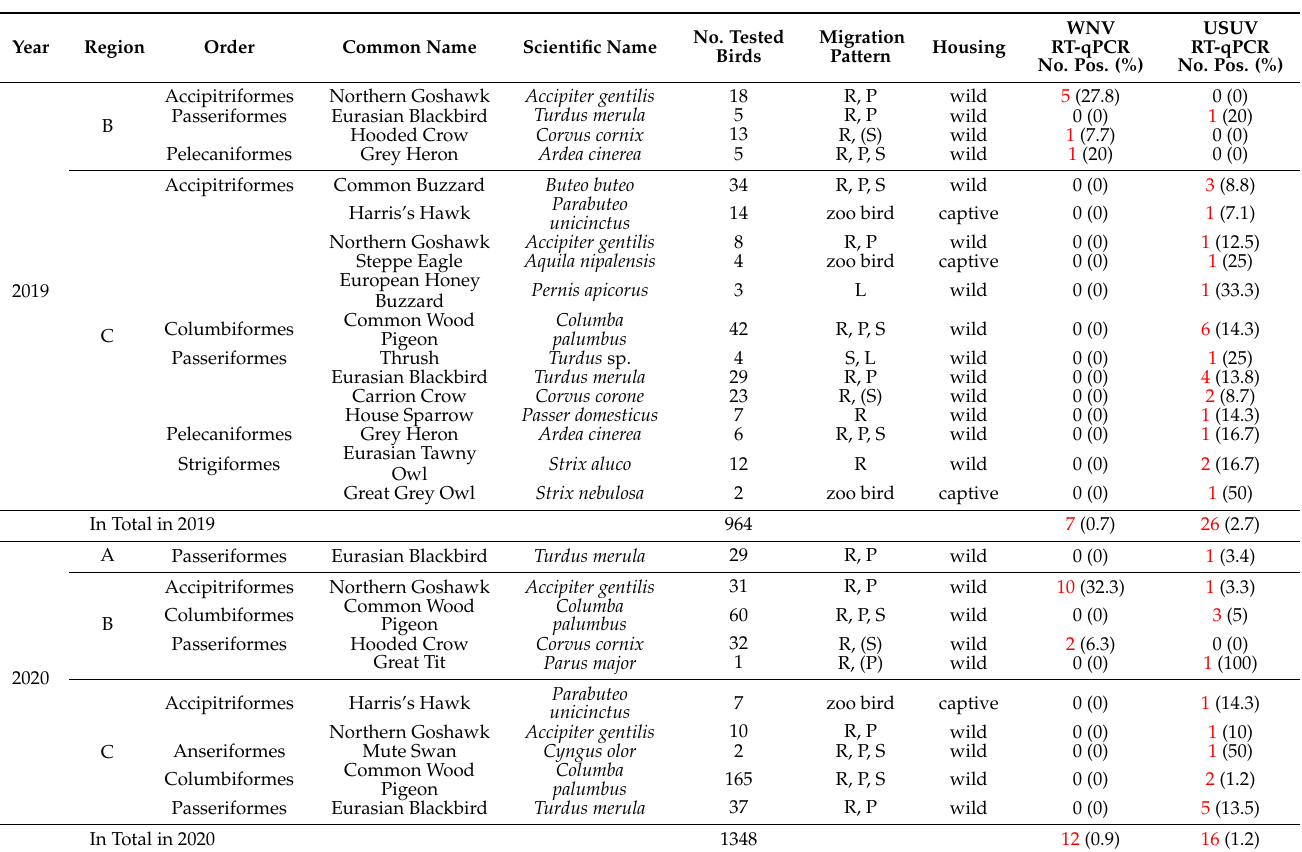
Table 2. Positive results of RT-qPCR among blood samples (first panel) from birds collected in three regions of Germany from 2019 to 2020 with the relevant flavivirus highlighted in red. The 2019 results include five WNV RNA positive samples from ten clinically affected free-ranging northern goshawks, which have already been reported